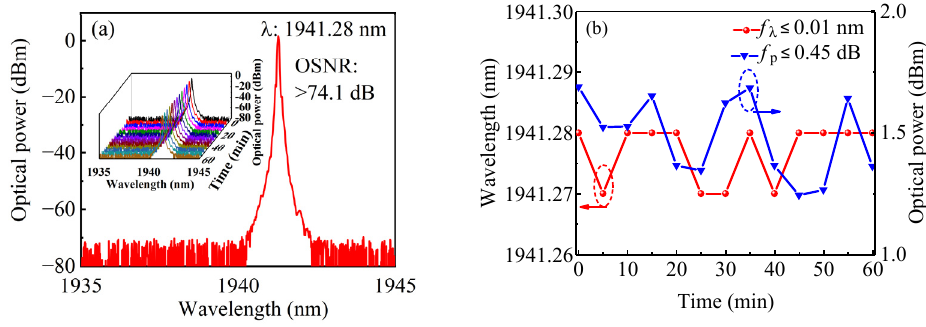
Figure 5. ( a ) Measured optical spectrum of proposed TDFL with pump power of 2.1 W. ( b ) Fluctu- ations of wavelength and power of 1941.28 nm.